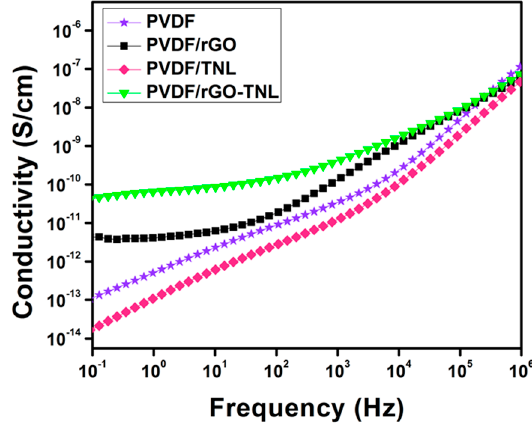
Figure 15. Conductivity vs. f at 20 °C for the PVDF composite samples with various nanofillers.